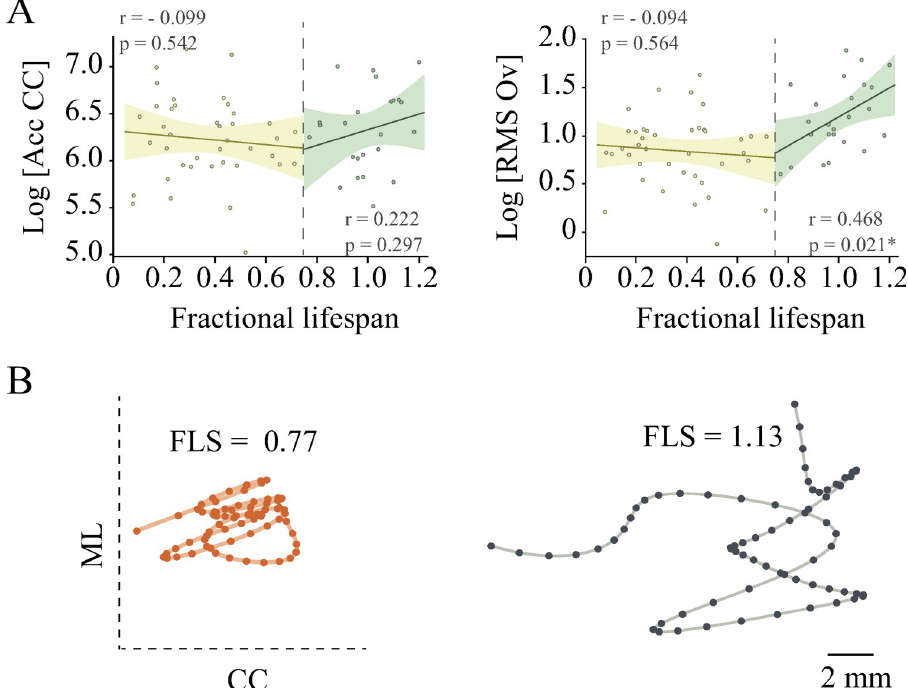
Fig 3. Correlation between fraction of lifespan and COP measurements in younger and older dogs. The linear regression between fraction of lifespan and the two COP measurements was evaluated for each group of dogs independently (A). For easier visualization both are shown in the same graph separated by a black dashed line. At the bottom of the figure (B) there are two examples of COP displacement after 5 Hz low pass filtering in two senior dogs with extreme fractional lifespan values.